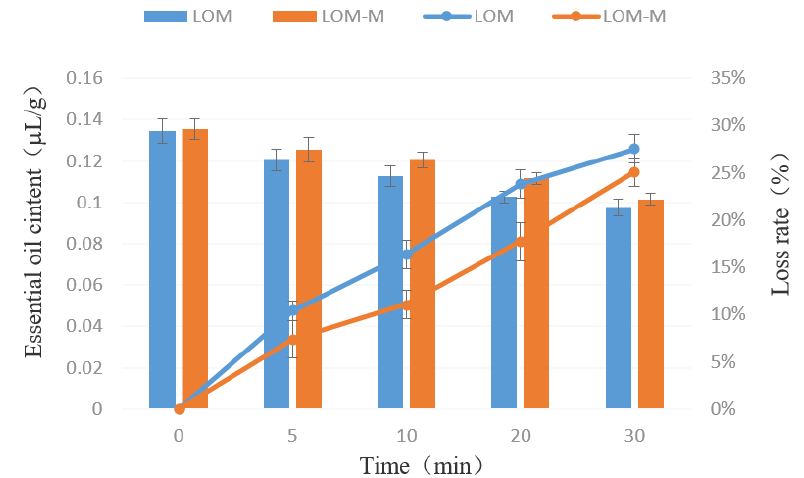
Figure 6. The release of lavender essential oil in single-layered microcapsules (LOM) and double-layered microcapsules (LOM-M) at high temperatures.